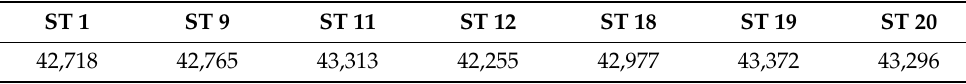
Table 3. Total observations after missing values